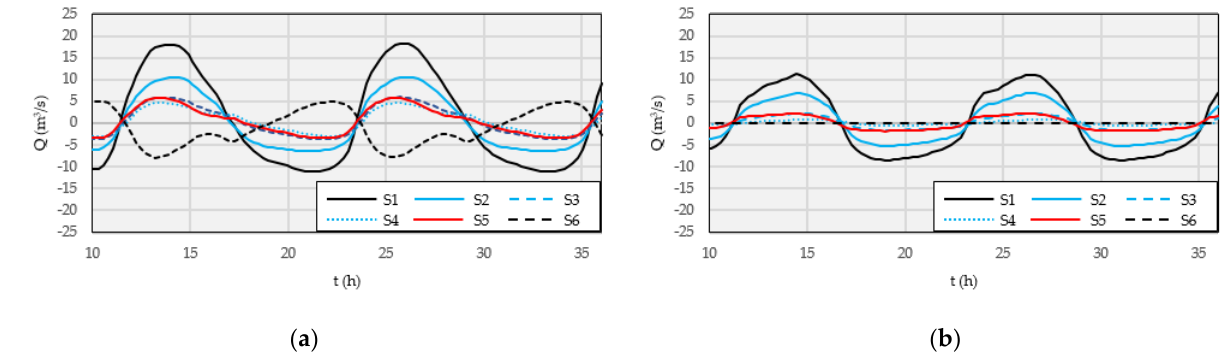
Figure 13. Water flow through selected cross sections resulting from tidal simulation with no wind forcings: ( a ) Reference configuration; ( b ) Closure of the Taglio channel. Table 3. Maximum discharge Q through selected cross sections resulting from the tidal simulation with no wind forcings, in the reference configuration and in the case of a complete closure of the Taglio channel.